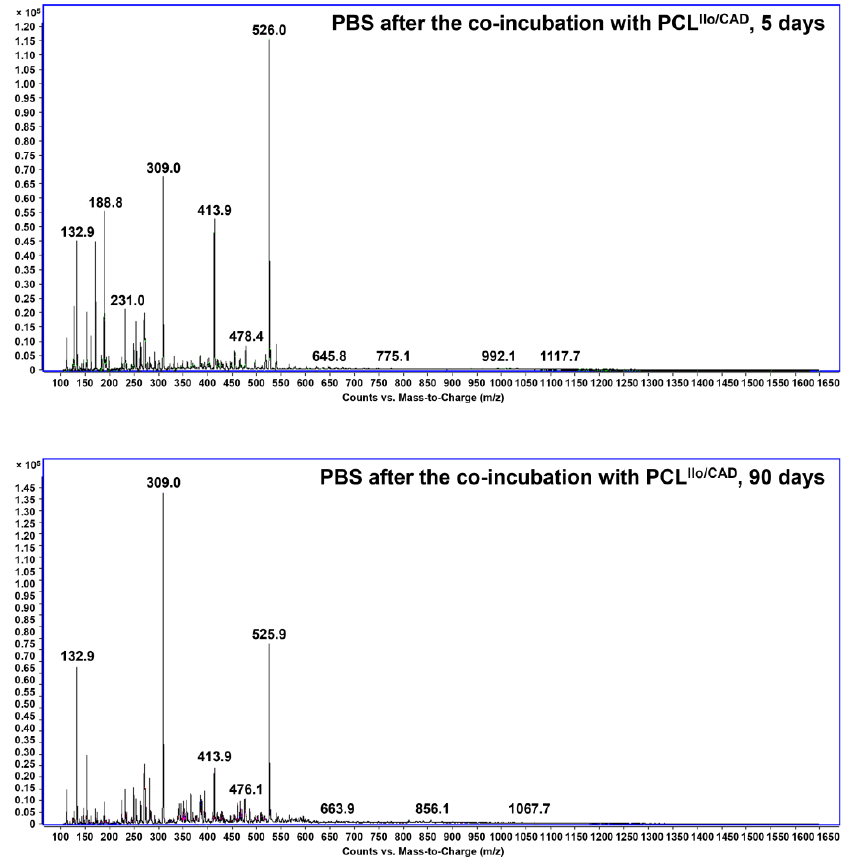
Figure 5. Liquid chromatography-mass spectrometry analysis of PBS samples after incubation with PCL Ilo/CAD TEVGs for 5 (top) or 90 (bottom) days.